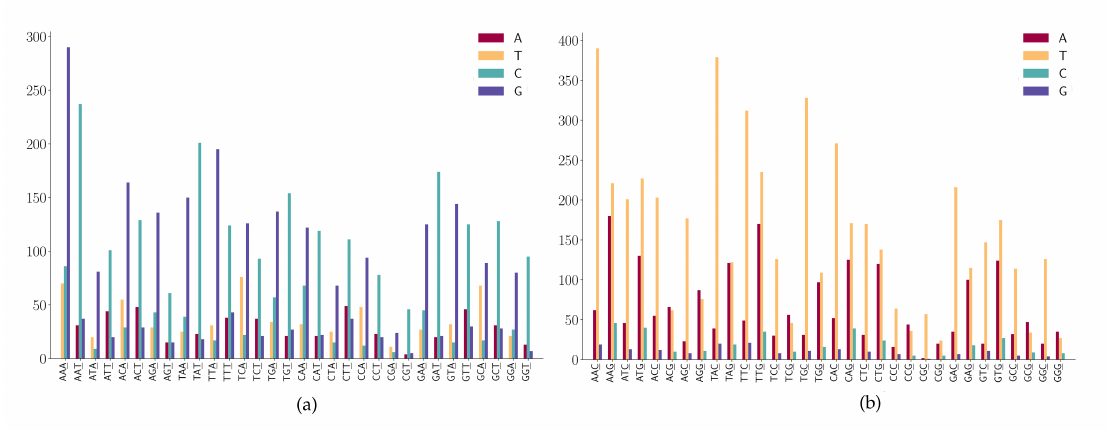
Figure 9. SNP frequency at the third position of the 3-mer motifs. ( a ) A or T is at the third position of 3-mer motifs. ( b ) C or G is at the third position of 3-mer motifs.